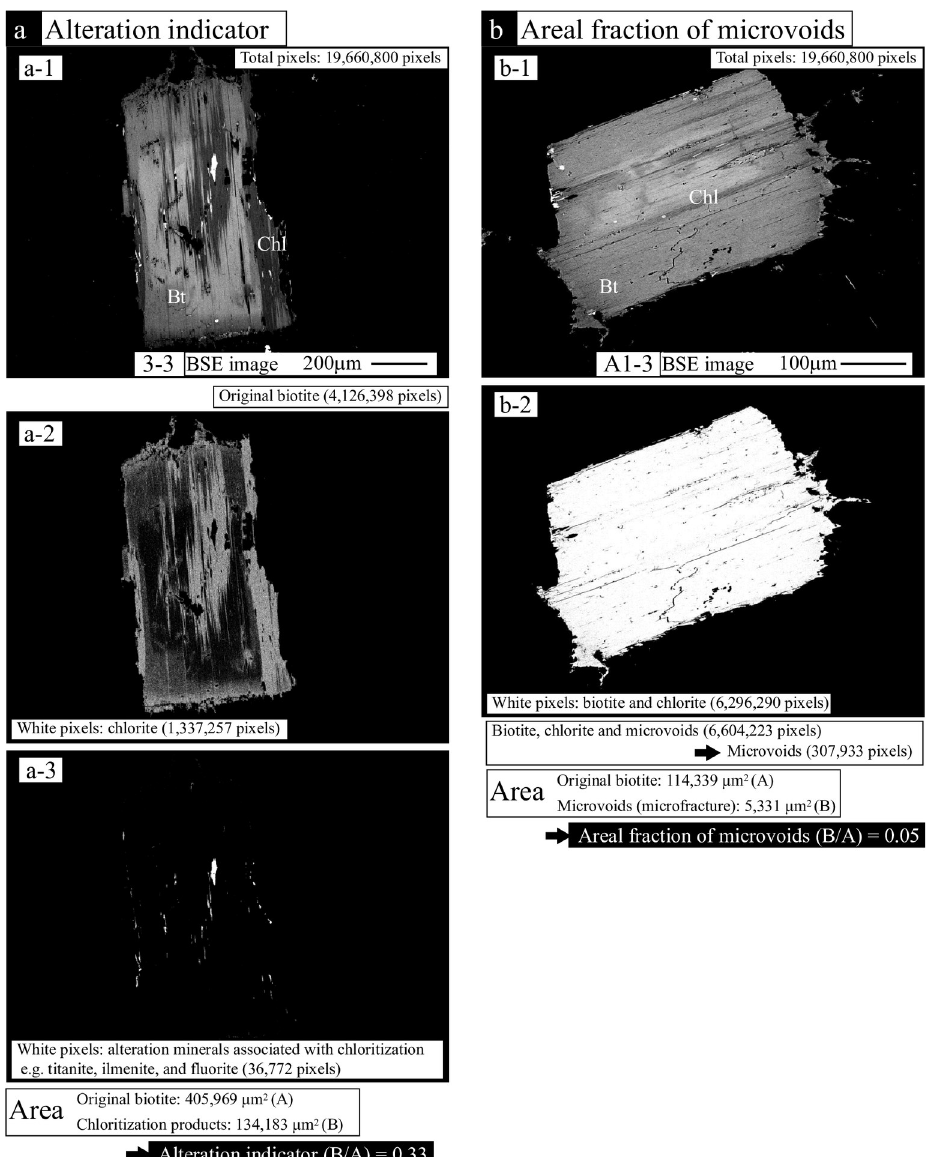
Fig 4. Example images showing the processing technique using Adobe Photoshop 1 to reveal the alteration indicator (a) and the areal fraction of microvoids (microscopic fractures and micropores) in the chloritized biotites